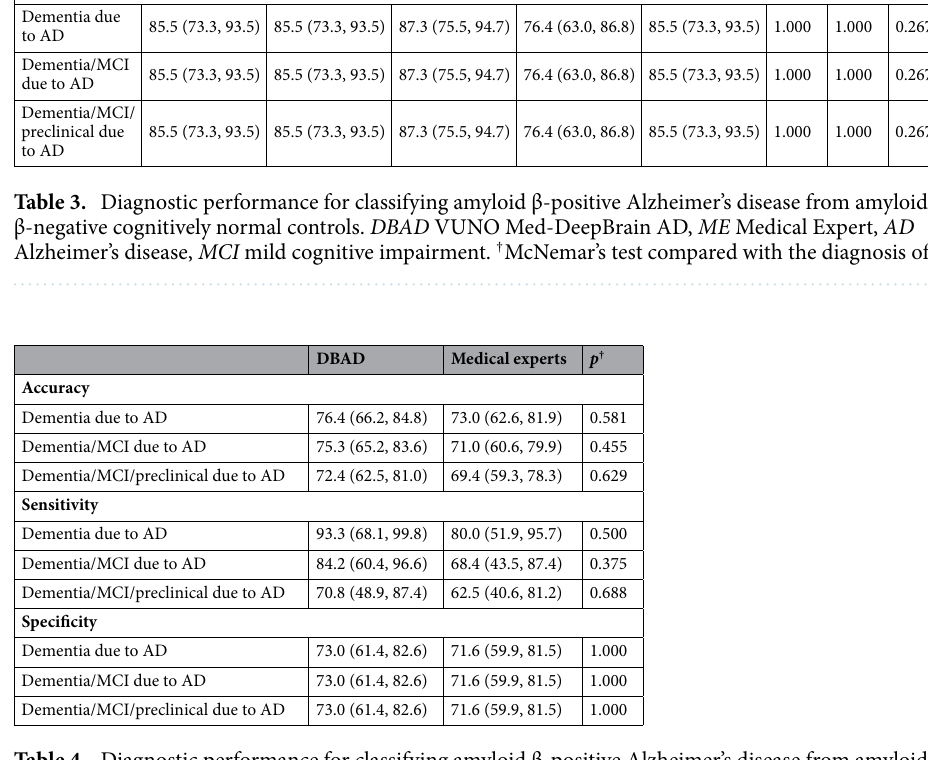
Table 4. Diagnostic performance for classifying amyloid β-positive Alzheimer’s disease from amyloid β-negative controls. DBAD VUNO Med-DeepBrain AD, AD Alzheimer’s disease, MCI mild cognitive impairment. † McNemar’s test compared with the diagnosis of